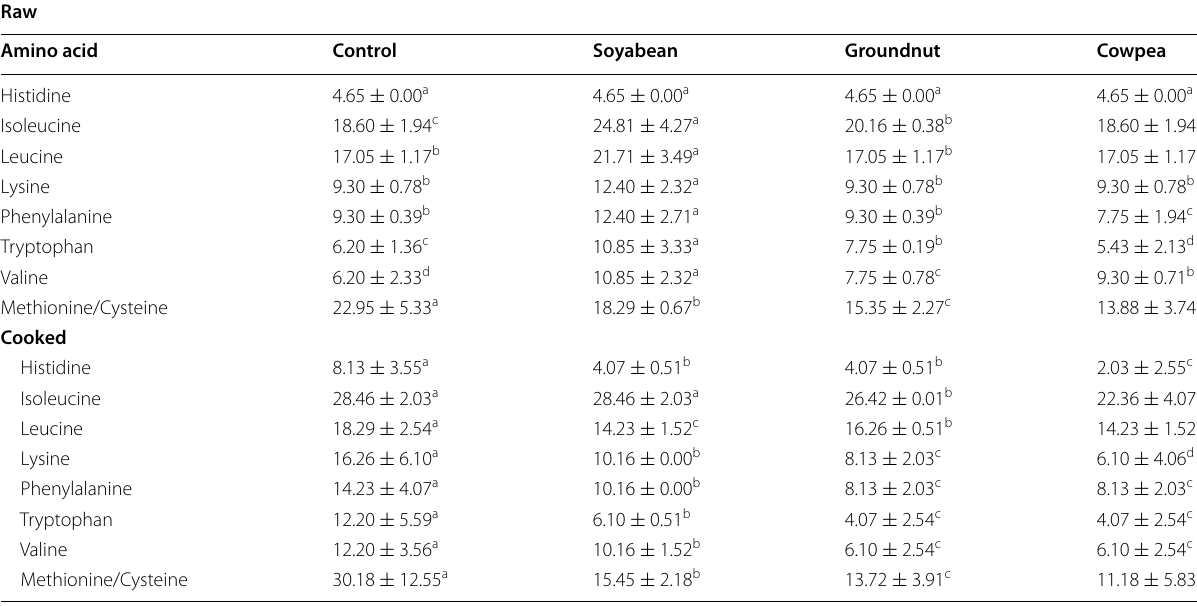
abcd Means in the same row with varying superscripts are significantly different ( P <